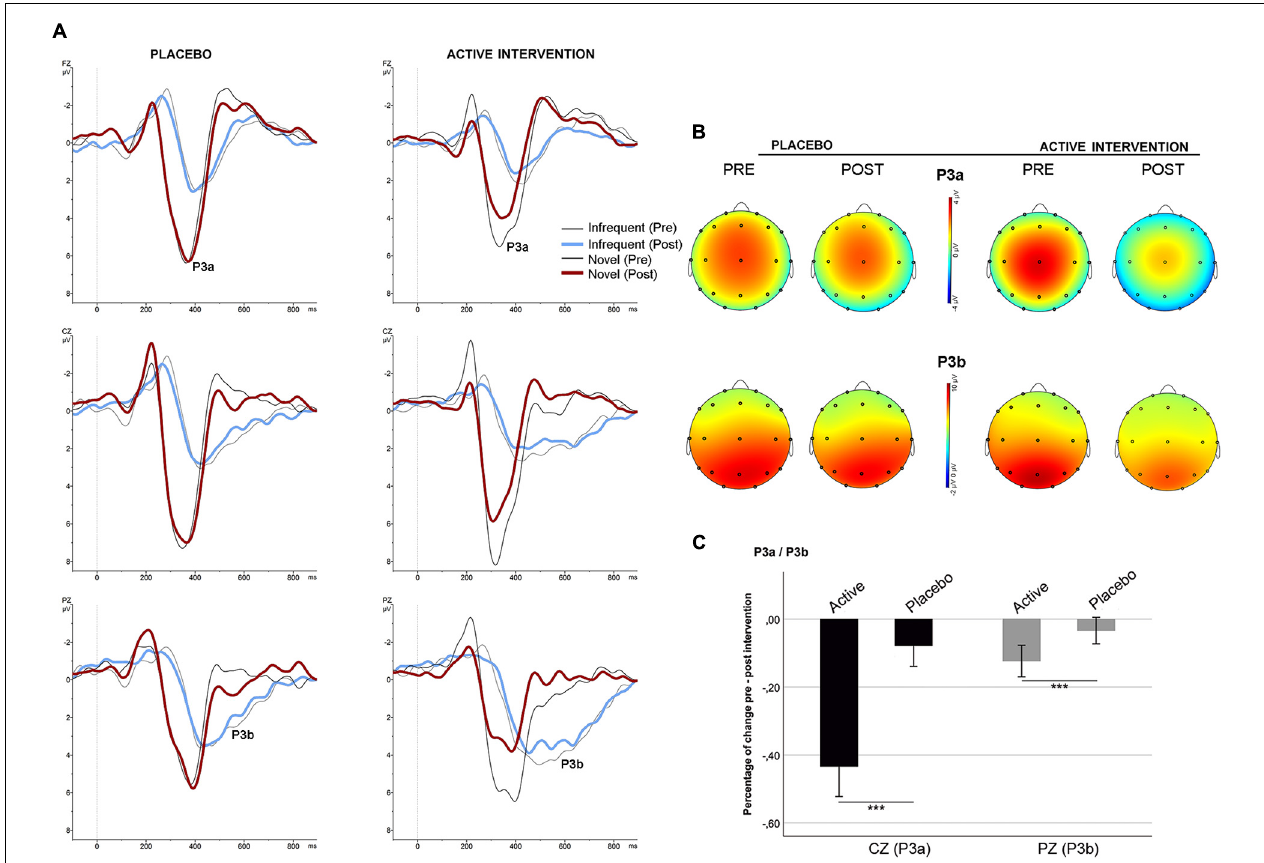
FIGURE 4 | Stimulus-locked (grand average) ERPs for the P3a/P3b. (A) ERPs after infrequent (gray/blue line) and novel (black/red line) stimuli in each group. (B) Topographical maps showing the pre-post intervention effects on the P3a and P3b. (C) Mean percentage of P3a and P3b change (in mV) between study groups. *** significantly different ( p <